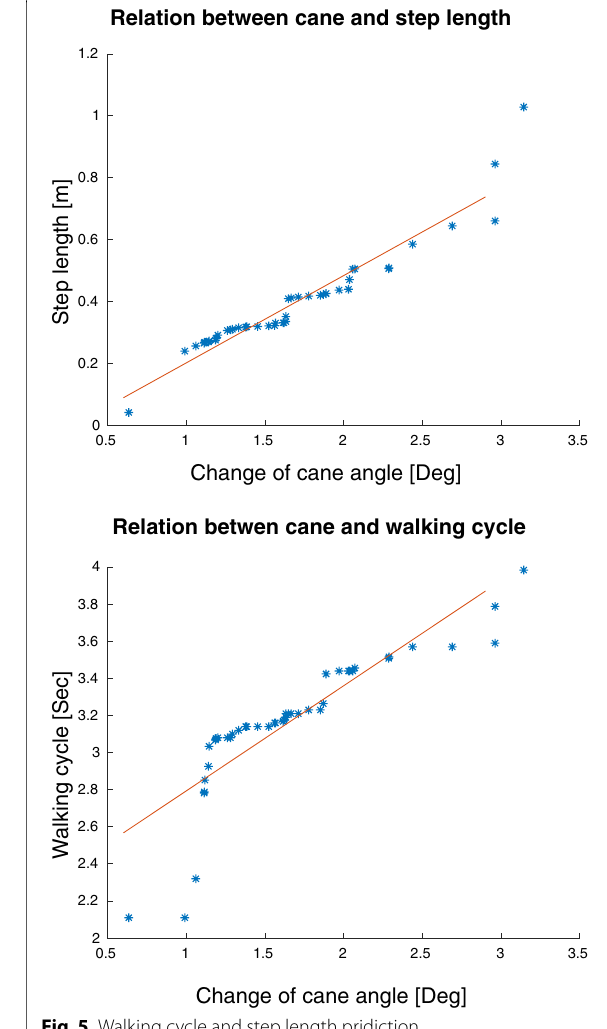
Fig. 5 Walking cycle and step length